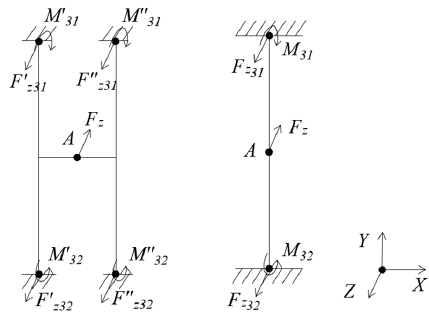
Figure 5. Mechanical models of floating beam and H-beam under F z.